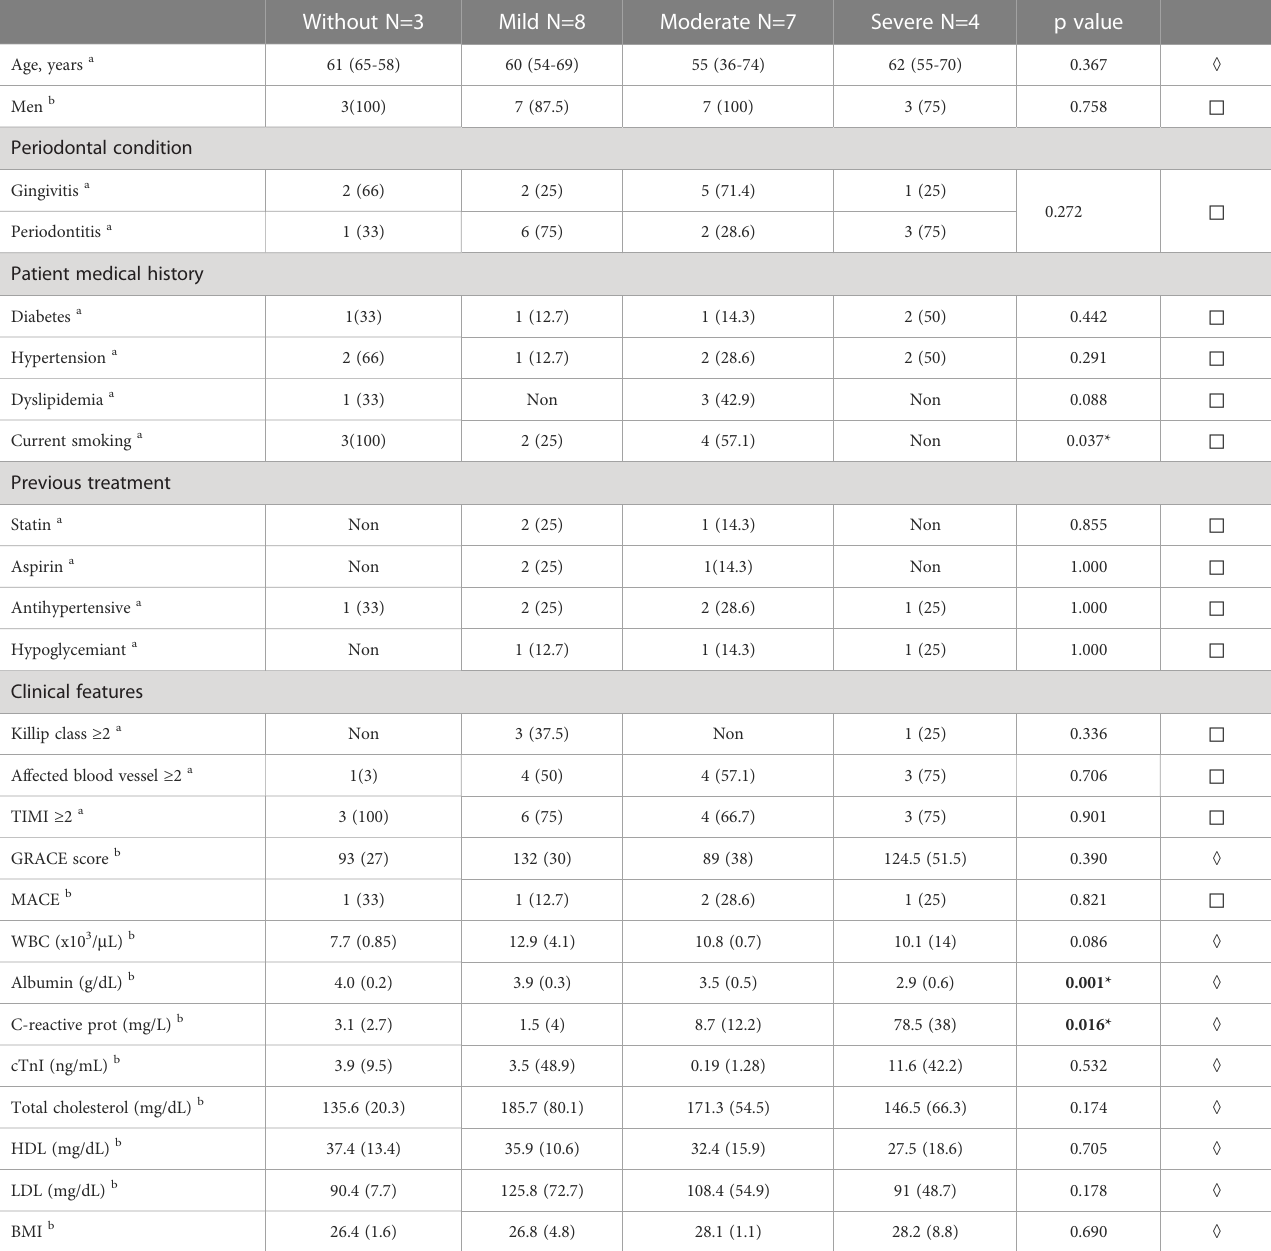
TABLE 1 Summary of cohort